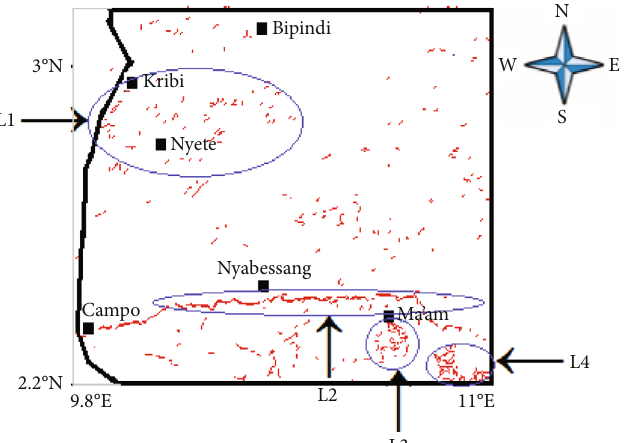
Figure 12: LST map of the region.